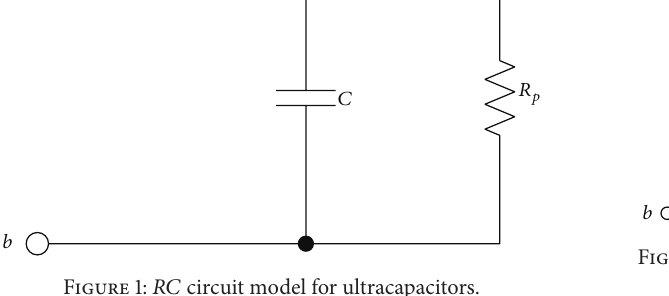
Figure 1: 𝑅𝐶 circuit model for ultracapacitors.